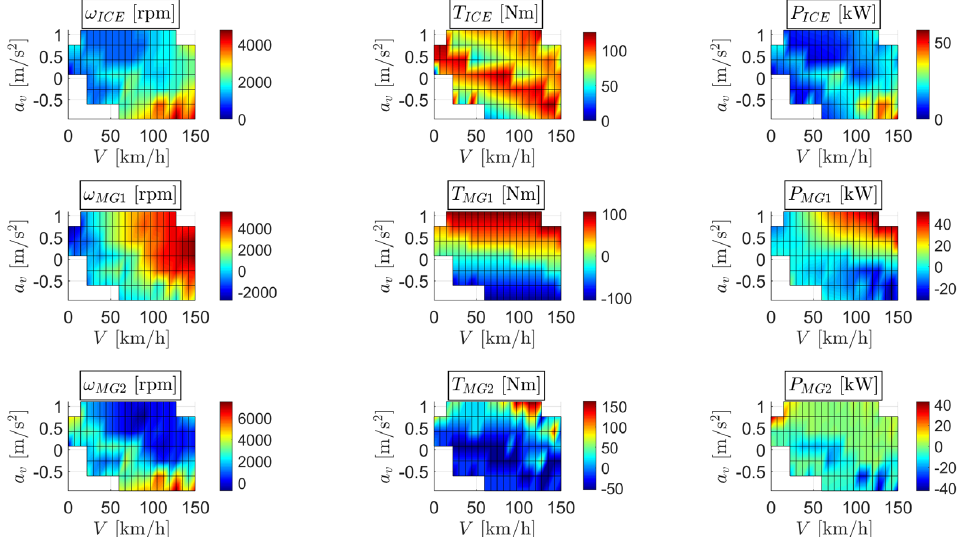
Figure 7. Angular speed ( left ), output shaft torque ( center ), and output shaft power ( right ) maps of the ICE ( top ), MG1 ( middle ), and MG2 ( bottom ) to achieve the lower penalized power-weighted efficiency for the Compound Split mode and road slope α = 0